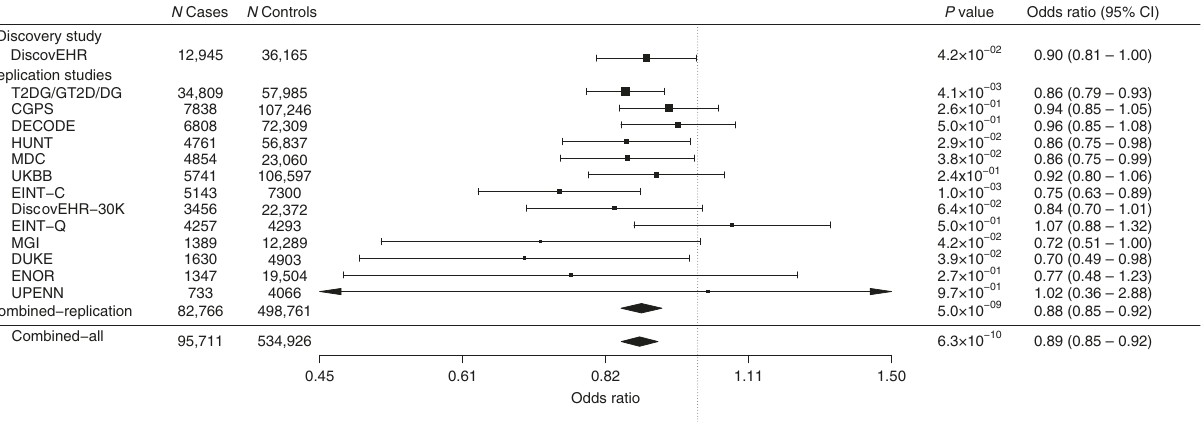
Fig. 1 ANGPTL4 p.E40K associates with reduced risk of type 2 diabetes. The association between the p.E40K variant and type 2 diabetes was tested in each study using logistic or Firth logistic regression, coding genotypes according to an additive model. “ Combined ” effects were calculated using inverse variance weighted fi xed-effects meta-analysis. For each study, the squares indicate the odds ratio and lines indicate 95% con fi dence intervals. The square size is proportional to the standard error of the estimate. CI con fi dence interval, CGPS Copenhagen General Population Studies, DECODE deCODE, DiscovEHR DiscovEHR Discovery Study, DiscovEHR DiscovEHR-30K, DiscovEHR 30K Replication Study, EINT-C EPIC interact – CoreExome, EINT-Q EPIC Interact – Quad660, ENOR EPIC Norfolk, HUNT the Nord-Trøndelag Health study, MDC Malmo Diet and Cancer Study, MGI the Michigan Genomics Initiative, TD2G/GT2D/DG combined analysis of T2D-GENES, GoT2D, and DIAGRAM studies, UKBB United Kingdom Biobank. The study populations